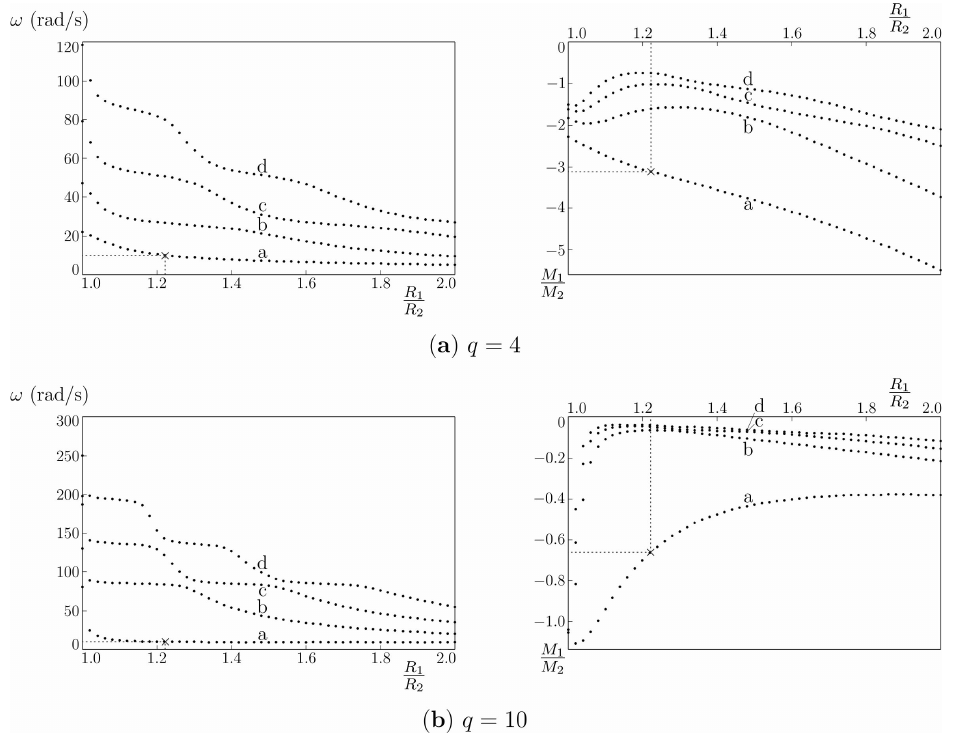
Figure 9. Frequencies ω of localised modes (left) and ratios of total masses M 1 / M 2 (right) as functions of the ratio R 1 / R 2 between the radii of the two rings, calculated for ( a ) q = 4 and ( b ) q = 10. For any ratio R 1 / R 2 , the first four solutions (labelled as a, b, c and d) are shown and indicated by dots. In the computations, R 2 = 4.5 m and ( a ) M 2 = 802.686 kg and ( b ) M 2 = 10,609.7 kg, as in Figures 1 and 5. The crosses represent the values of the frequencies and the mass ratios obtained in Figures 1 and